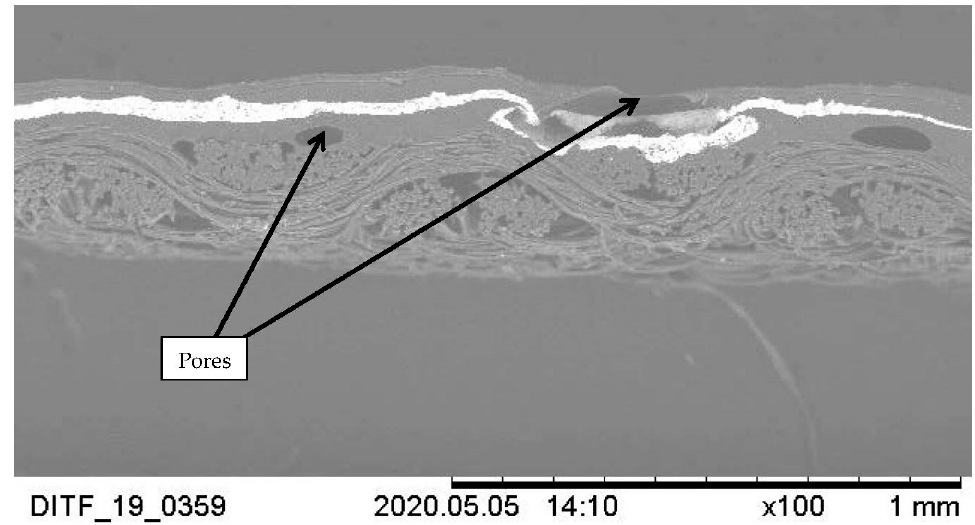
Figure 9. SEM image (cross section) of a sample coated once.